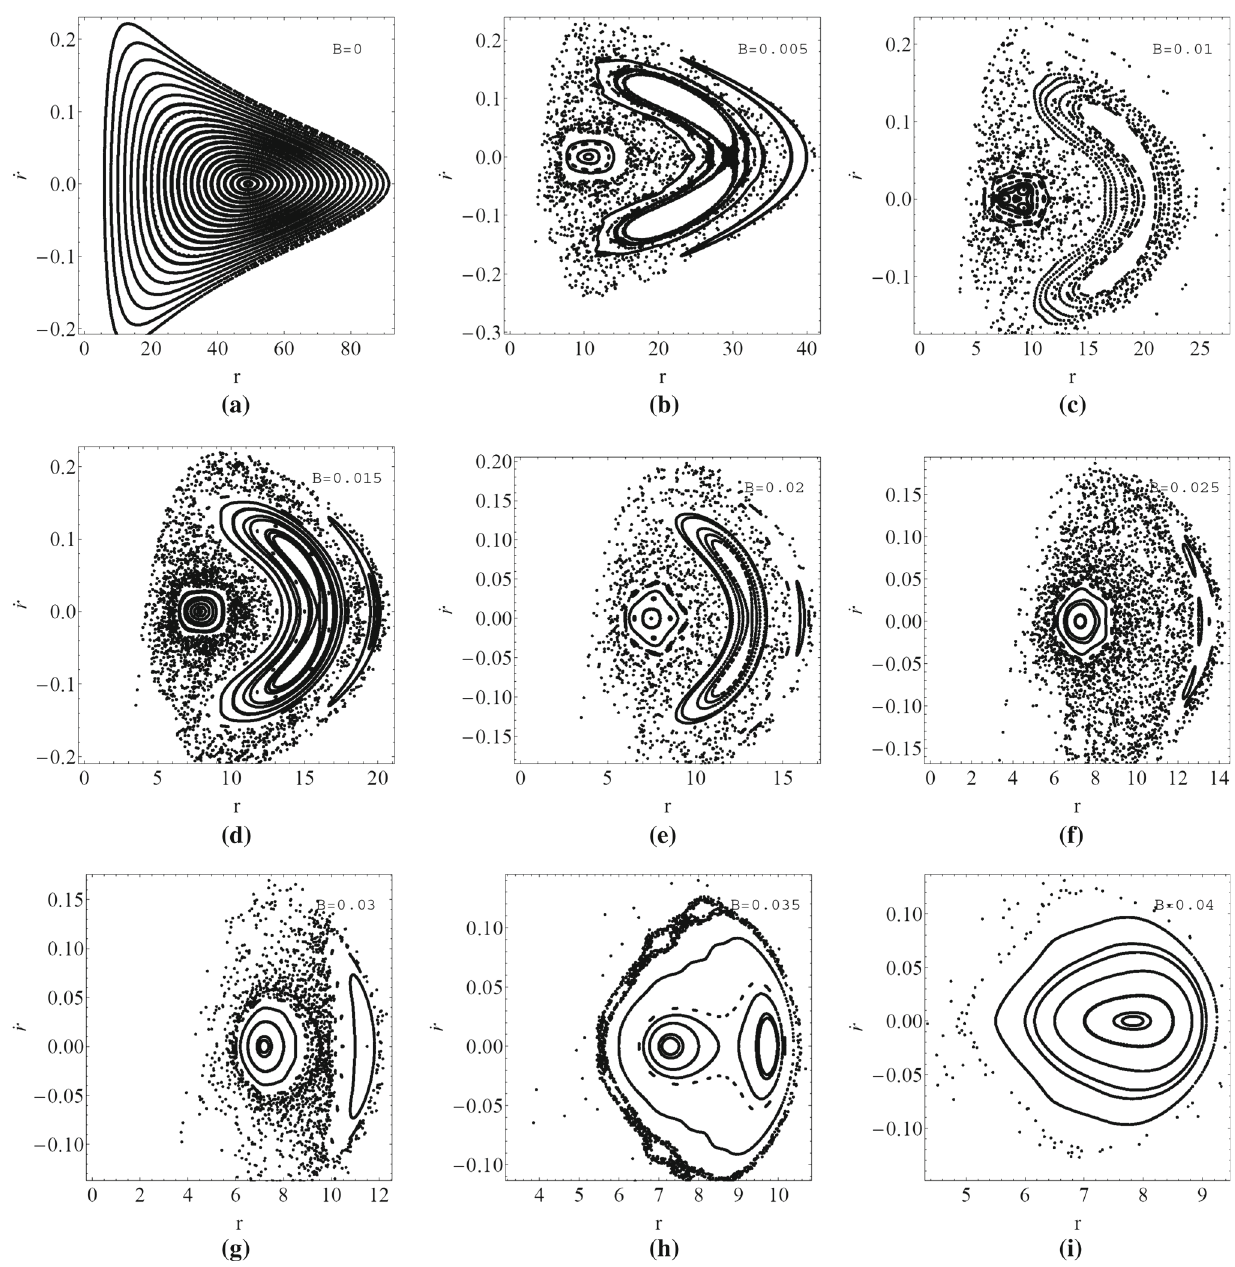
Fig. 7 The Poincaré surface of section ( θ = π